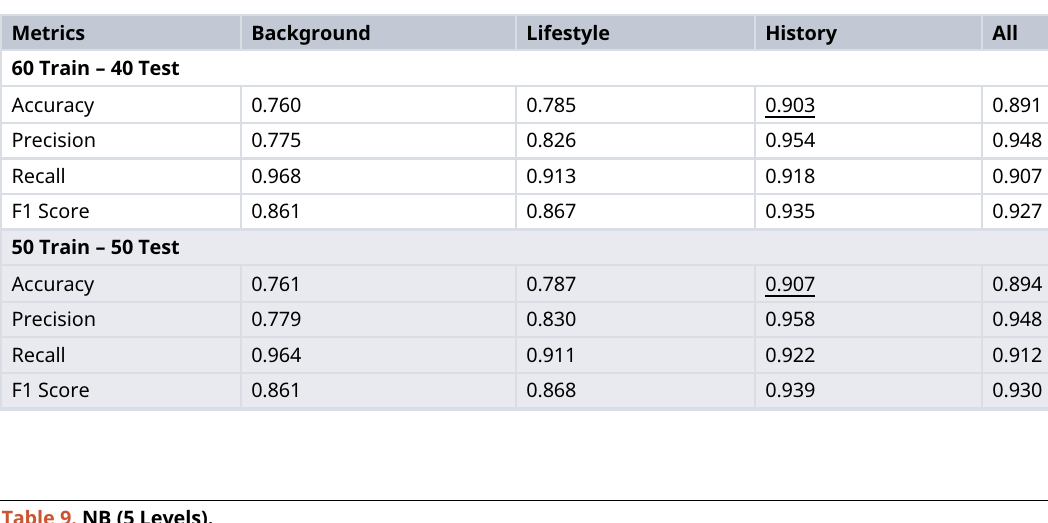
Table 8. NB (Binary